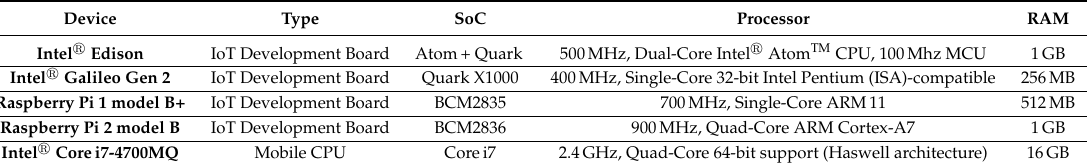
Table 3. Selected devices and their corresponding